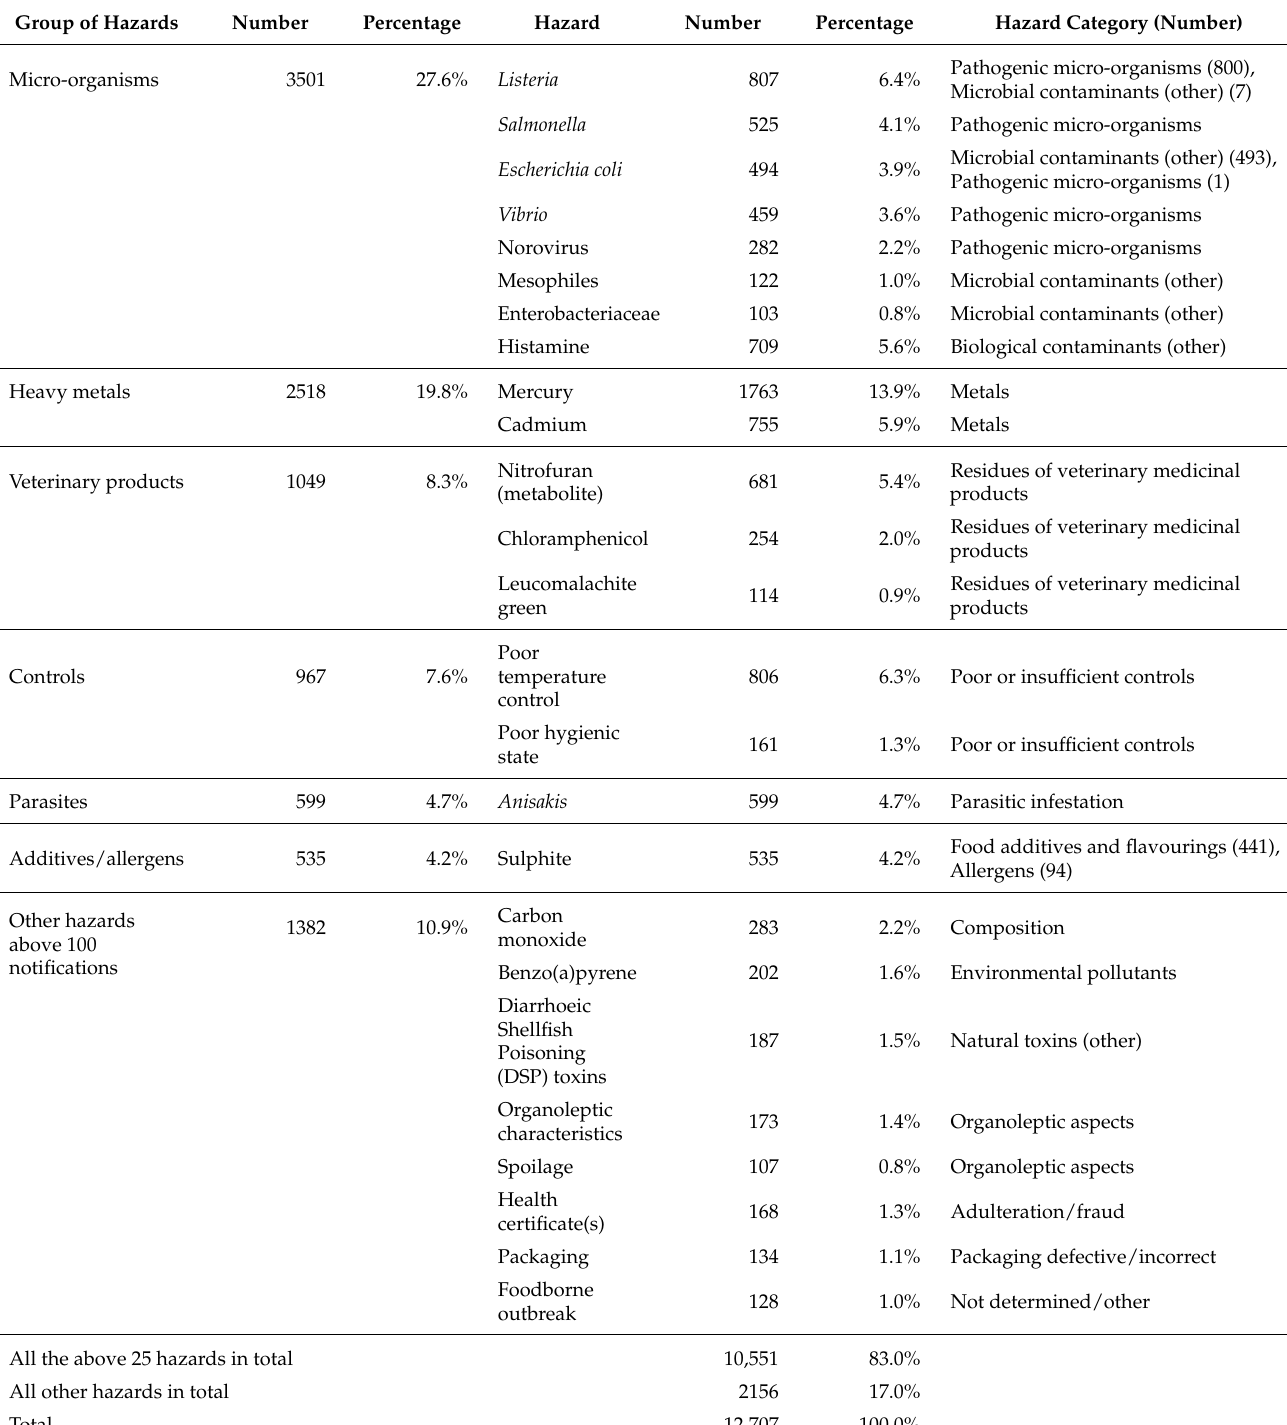
Table 2. Number of notifications on the 25 most frequently reported hazards and other hazards in seafood reported in the RASFF in